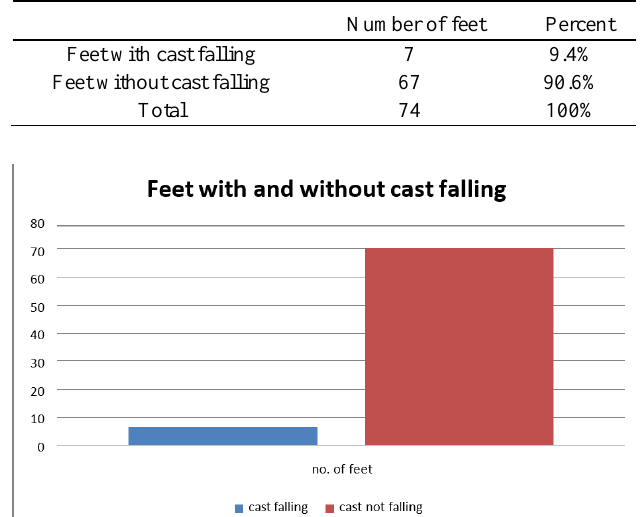
Table 2 : (feet with and without cast falling)